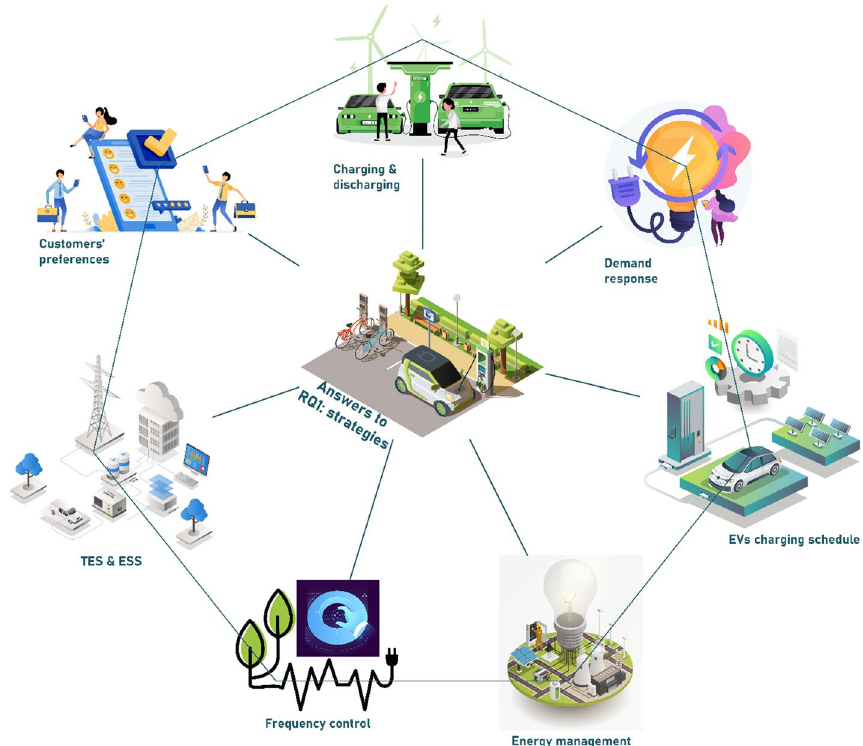
Fig. 2 Answers to RQ1‑ Analysis according to strategies used. Images are licensed. Design is made by